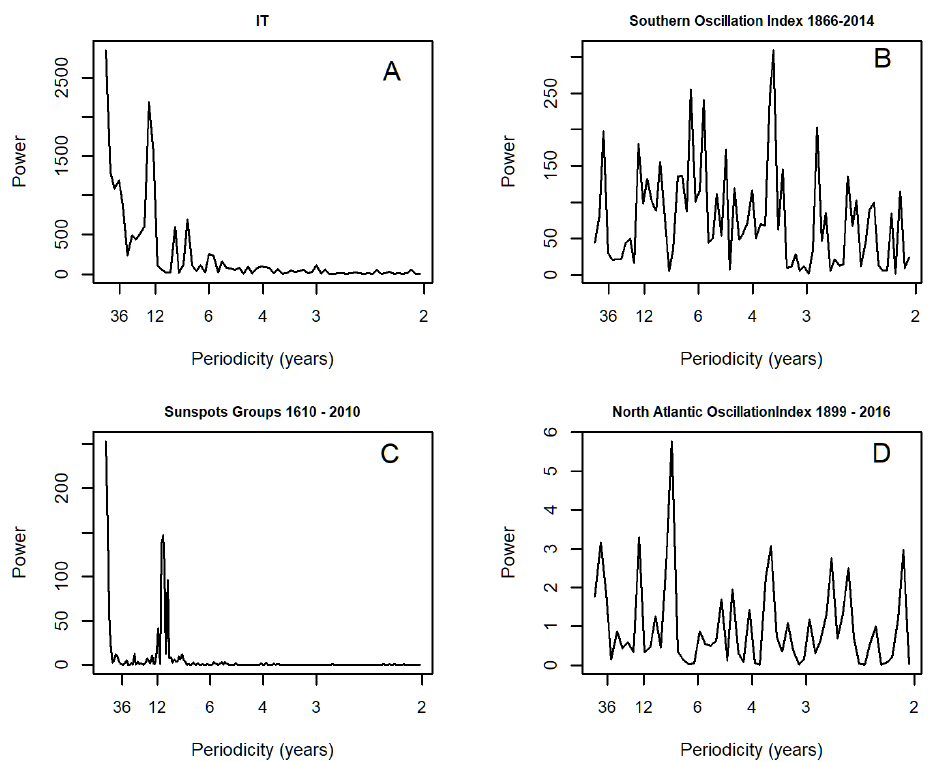
Figure 2. Periodograms of ( A ) the inferred Desert Locust series (IT), ( B ) the Southern Ocean oscillation Index (SOI), ( C ) the sunspot groups; and ( D ) the North Atlantic Oscillation Index (NAO).